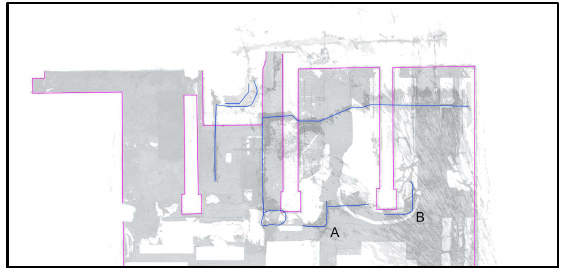
Figure 10 . Vector drawing. Purple: underground areas of the basilica (accessible nowadays). Blue: retracing of the SfM point cloud. A and B: foundation